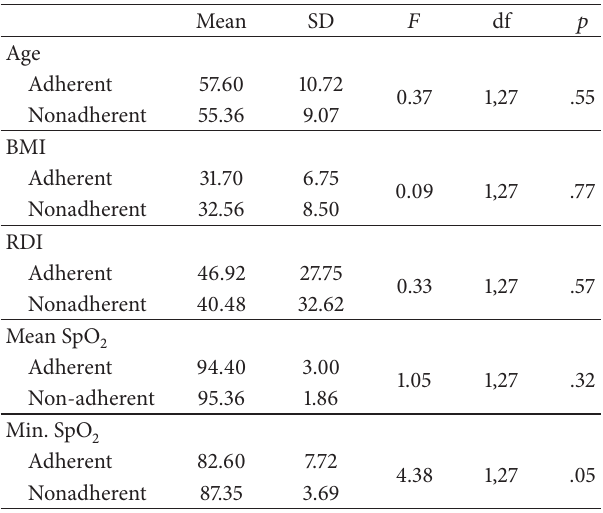
Table 1: Age, BMI, and PSG for adherent and nonadherent partici-